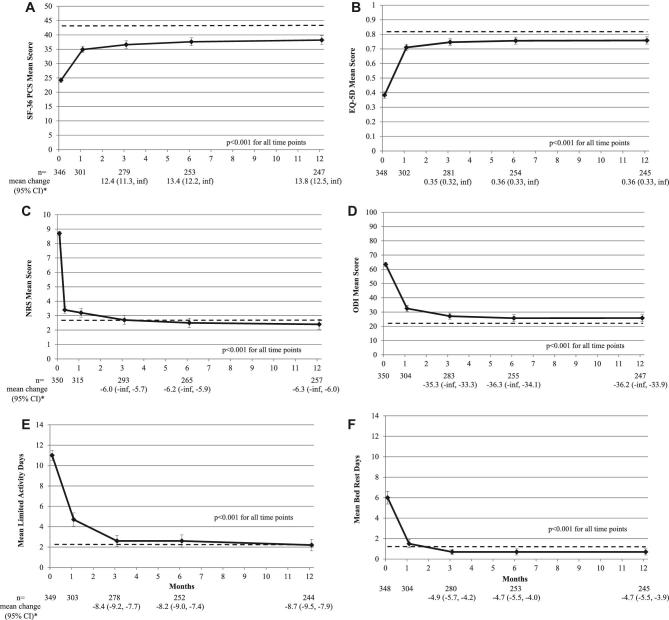
Quality of life, disability, and pain assessments at baseline and after balloon kyphoplasty. Raw mean scores and 95% confidence intervals (CIs) are shown as ‘error bars’ for balloon kyphoplasty (solid lines) for A, SF-36 PCS (scale 0-100); B, total EQ-5D scores (scale 0-1); C, back pain (scale 0-10); D, ODI (scale 0-100); E, limited activity days (scale 0-14); F, bed rest days (scale 0-14). The P-value in each panel is for all postoperative visits. Below each panel, the n for each group is shown for baseline, 3, 6, and 12 mo as well as the group average for change from baseline and 95% CI (in parentheses) for 3, 6, and 12 mo. Please note that for the coprimary endpoints in panels A–D, the 95% CI are 1-sided, reflecting the critical lower bound while the upper bound is infinity. The 95% CI reflected in panels E and F are 2-sided. The dashed line indicates the average prefracture estimation from EVOLVE patients for that parameter.